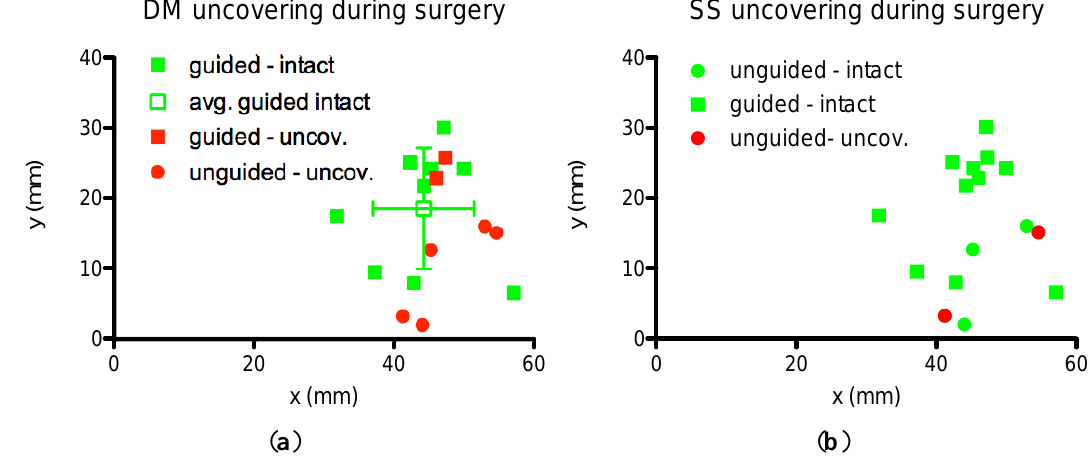
Figure 3. Position of the port relatively to the Henle spine (point 0,0) and the zygoma line ( x -axis). Green: intact structure; red: surgeries where ( a ) the DM; or ( b ) SS was uncovered; dots: unguided surgeries; squares: guided surgeries. The average and standard deviation of the position by guided surgeries leaving all structures